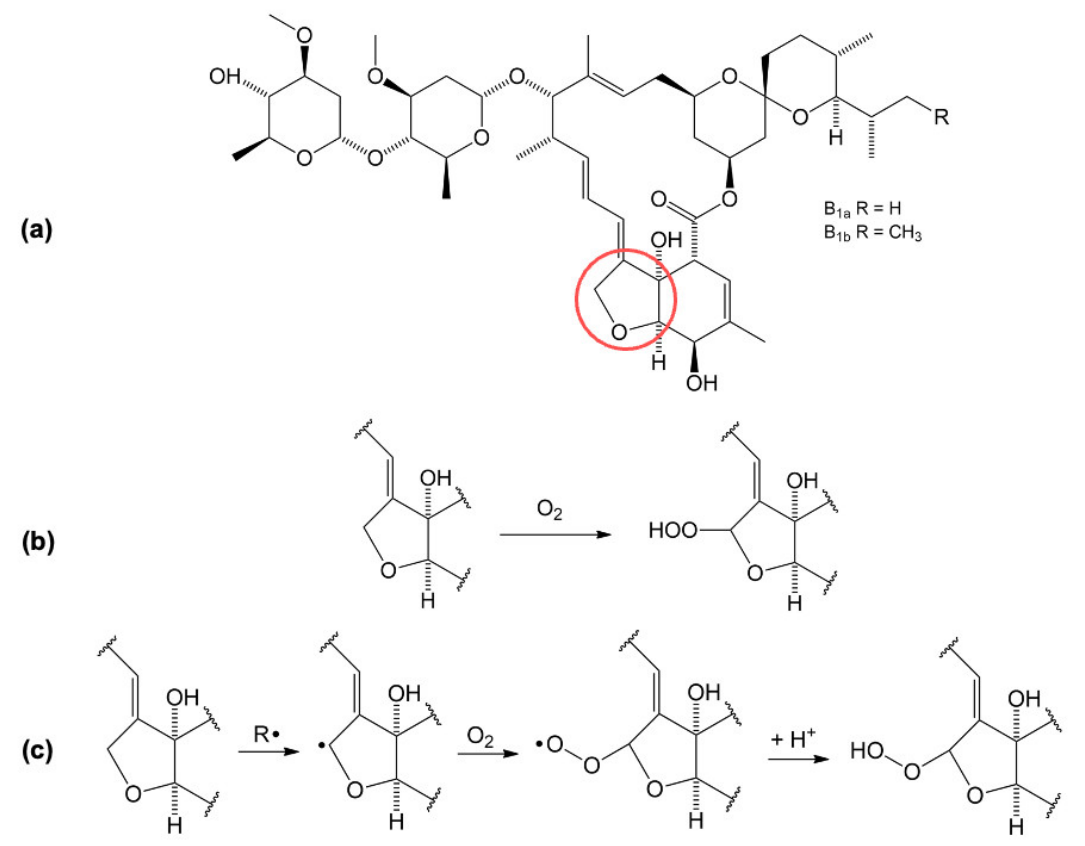
Figure 8. Oxidation reaction and reaction mechanism of IVM in serum; ( a ) IVM structure with oxidation site marked in red; ( b ) oxidation reaction; ( c ) oxidation reaction mechanism.